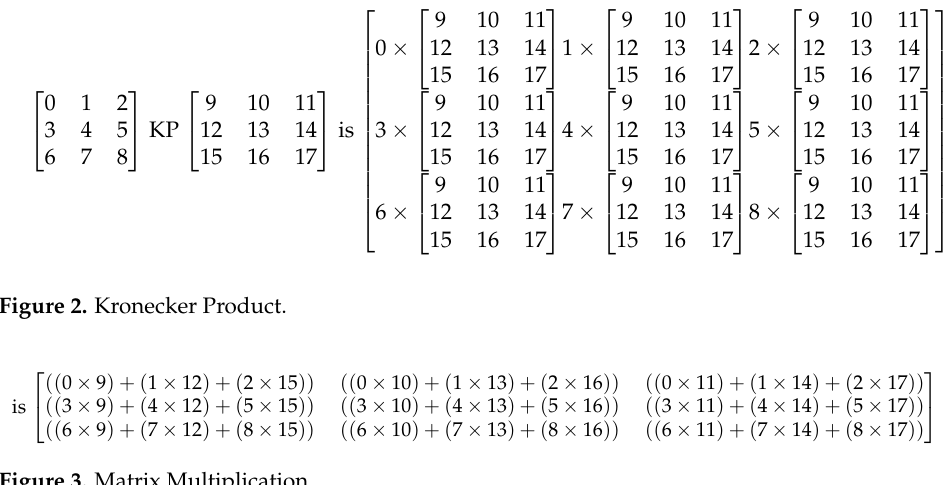
Figure 3. Matrix